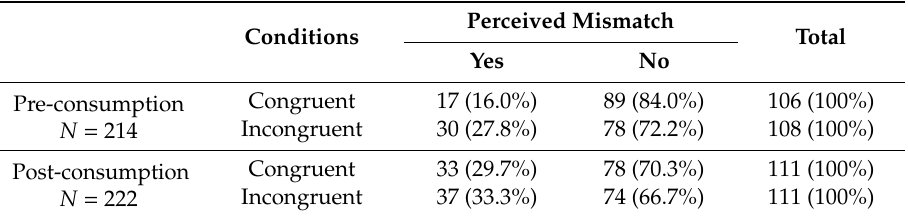
Table 4. Count and proportion (%) of perceived mismatch amongst (in)congruent conditions in pre- and post-consumption evaluation.